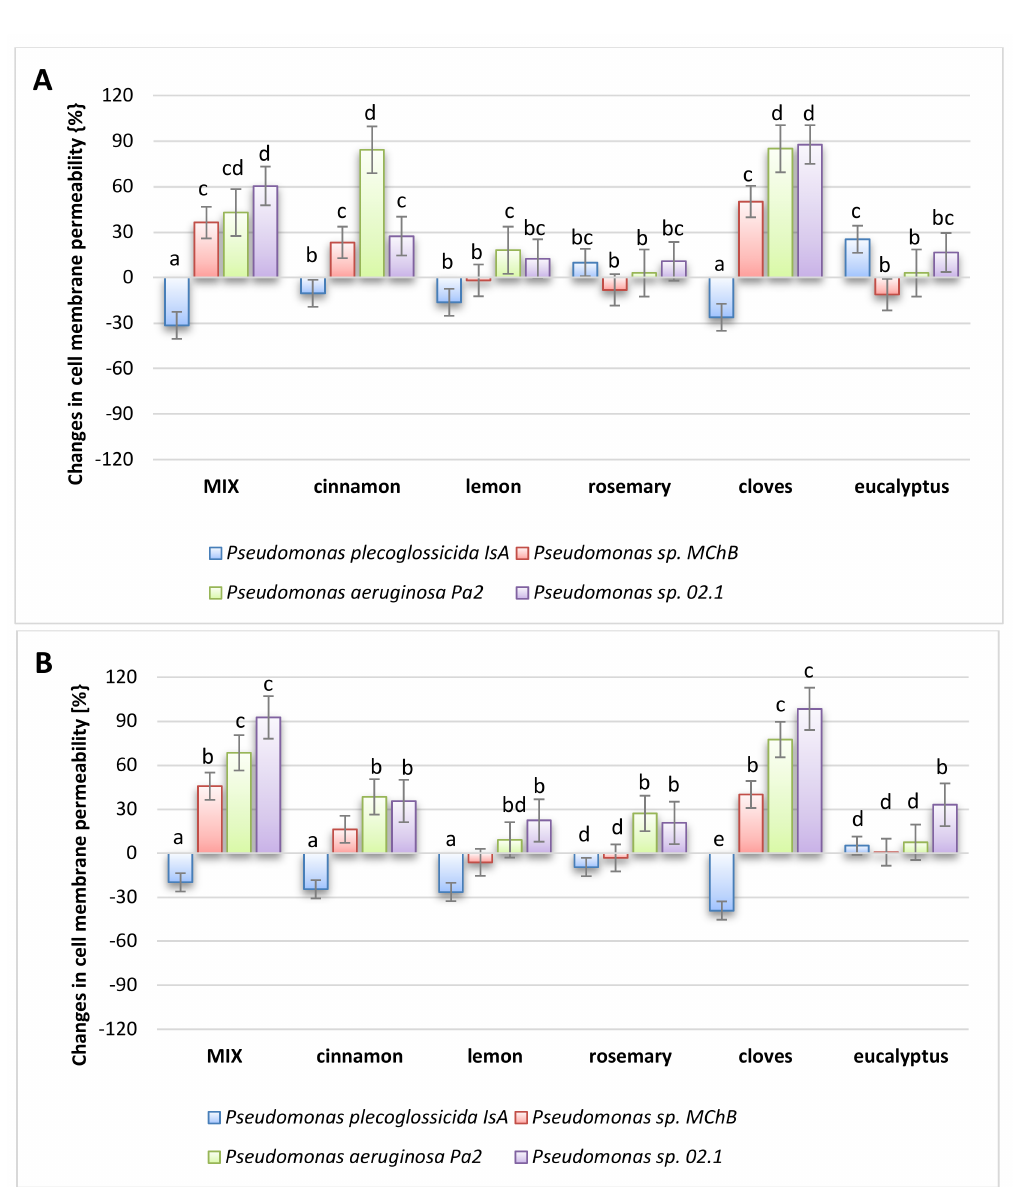
Figure 9. Changes in bacteria cell membrane permeability in ( A ) fresh oils, ( B ) oils after 4 weeks. The different small letters indicate groups of the results that differ statistically